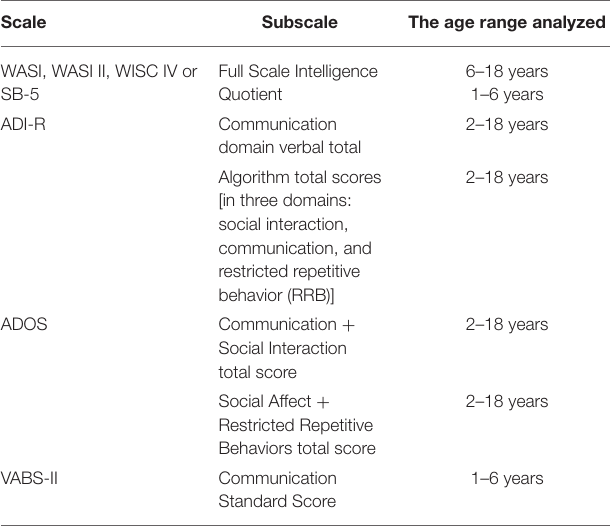
TABLE 2 | Clinical measures analyzed in our ASD